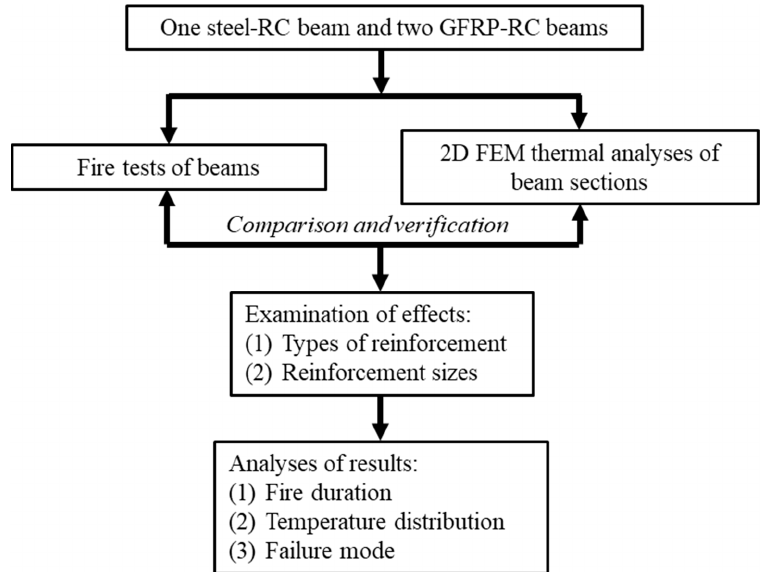
Figure 1. Flowchart of the research program.